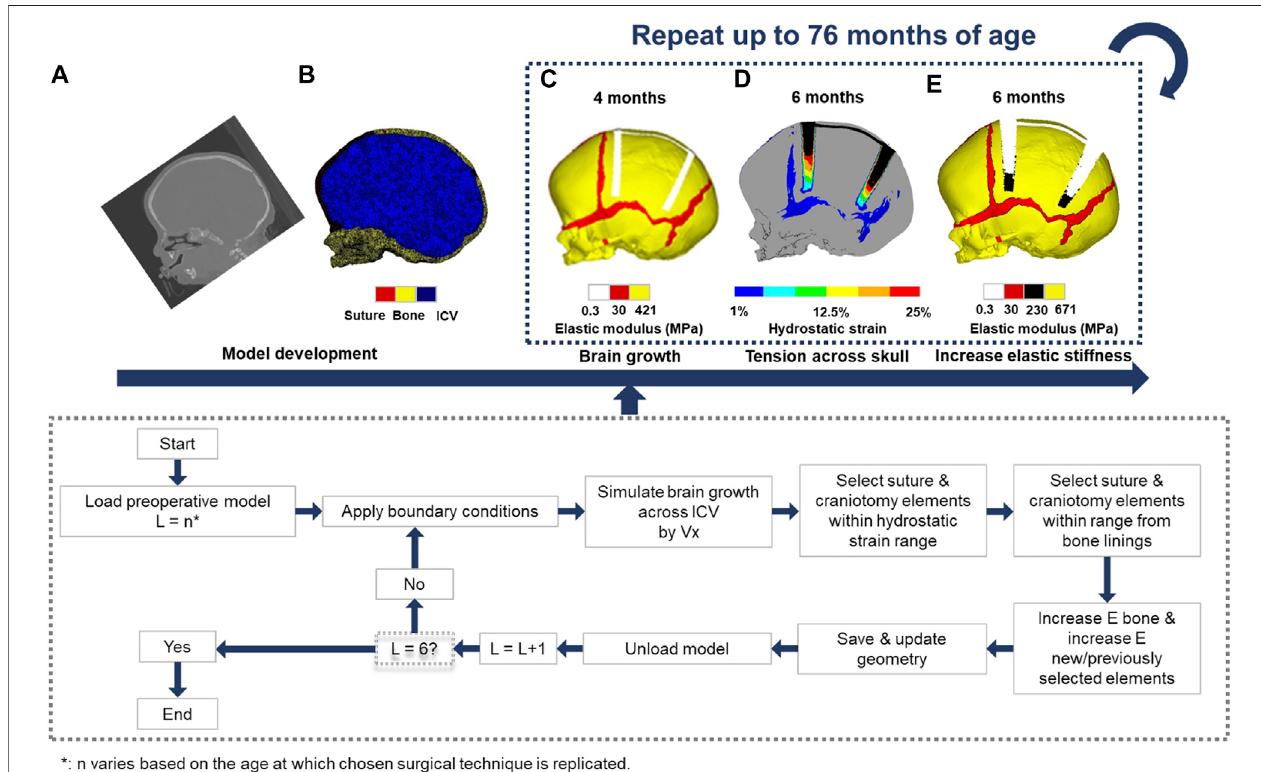
FIGURE 1 | Using CT -scan data at an initial preoperative age of4 months (A) , a 3D fi nite element model was developed (B) . The chosen surgicaltechnique at the appropriateagewasperformed (C) .Theintracranialvolumewasthenexpandedtoaspeci fi edvolumein6loadsteps (D) .Elementsacrossthesuturesandcraniotomies werethenselectedbasedonthelevelofhydrostaticstrainand/orradiiprocessfromthebonelining,followingthealgorithmdescribedinthe fl owchart.Thisprocesswas repeated while updating the material properties and geometry of the model at each load step until the fi nal load step has been reached (E) . The intracranial volume at the fi nal load step was equivalent to 76 months of